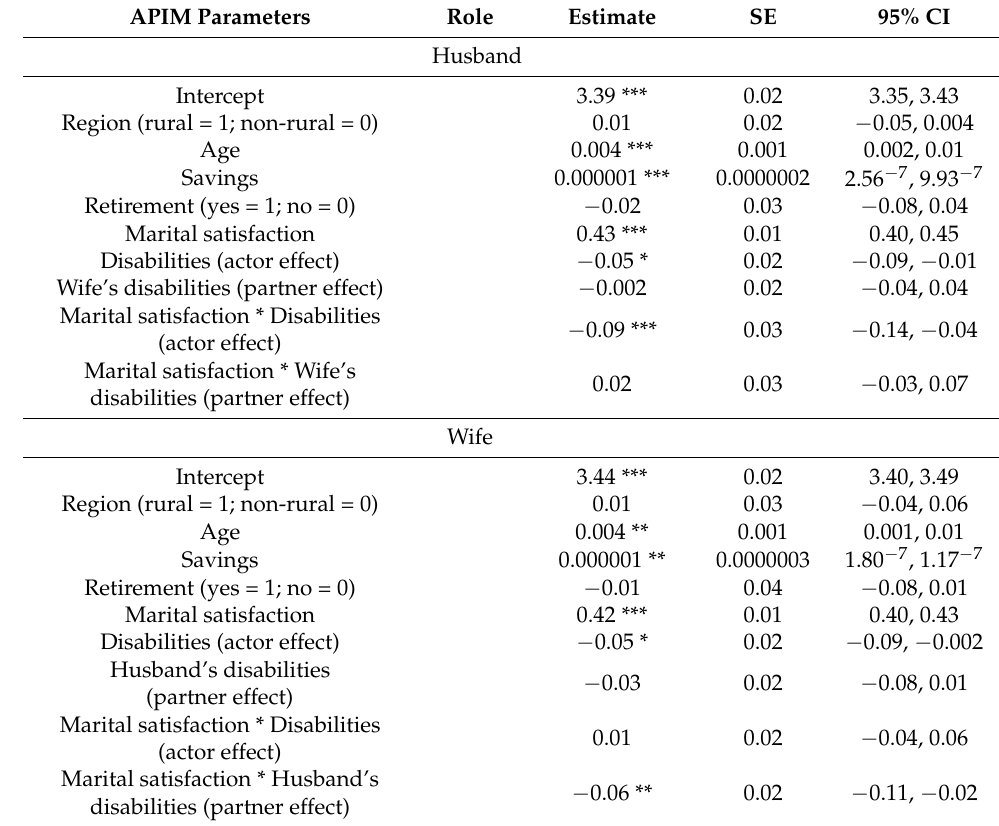
Table 2. The results of APIM for the moderating role of marital satisfaction on the dyadic effect of overall disabilities on life